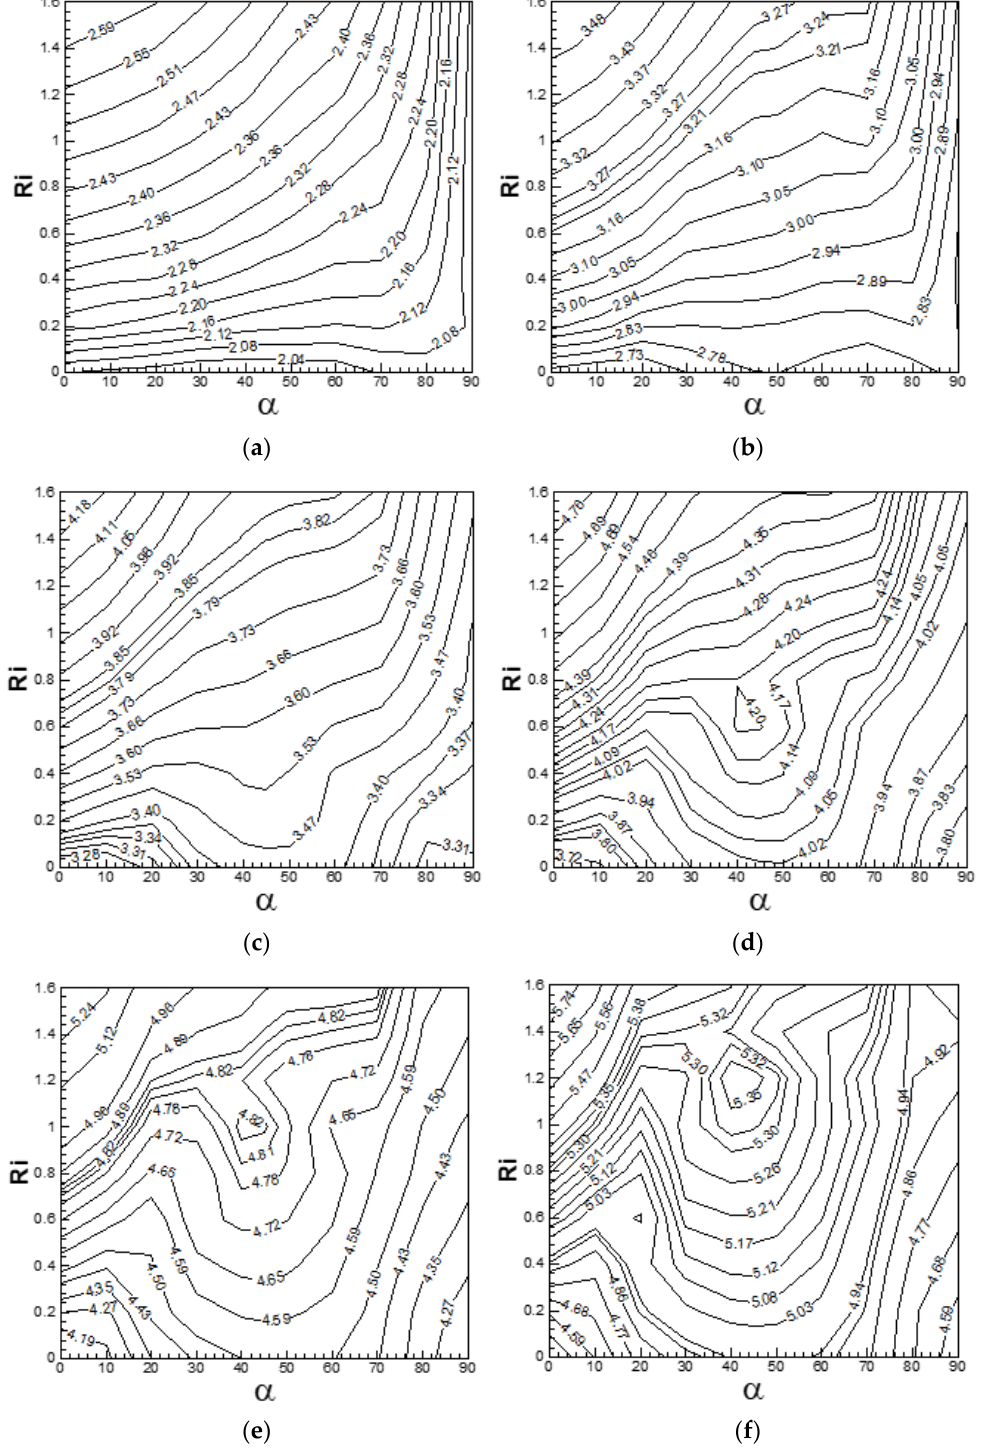
Figure 35. Contour map of the mean/steady Nusselt number (Nu) in α —Ri plane at ( a ) Re = 20, ( b ) Re = 40, ( c ) Re = 60, ( d ) Re = 80, ( e ) Re = 100 and ( f ) Re = 120.